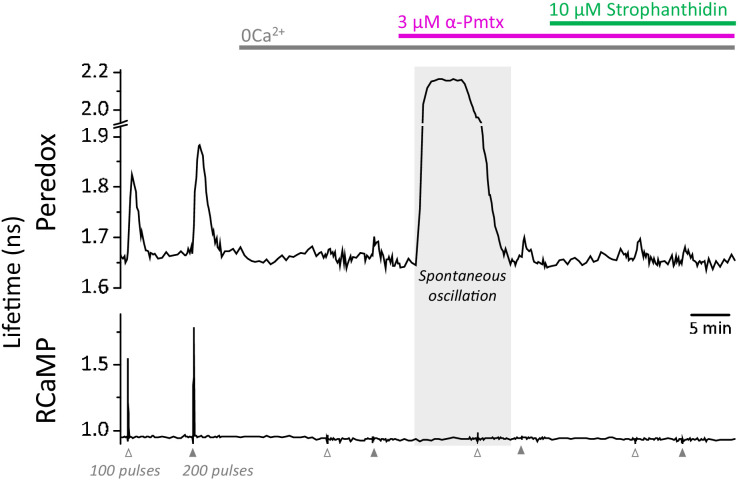
Spontaneous oscillations in the Peredox signal may occur during the prolonged application of zero Ca2+-ACSF, in the presence of EGTA and LDH inhibition.Prolonged exposure to a nominal Ca2+-free solution, plus LDH inhibition, caused spontaneous elevations of the Peredox lifetime in 25 ± 13% of the cells in each slice (slices = 10, mice = 5), contrasting with only ~3% of cells exposed to a brief exposure as in Figure 4c. The spontaneous elevations in Peredox lifetime occurred at any time after removing Ca2+ from the ACSF. Although these neurons were not included in the analysis, once the spontaneous transients cleared, the experiment resumed as usual. The continuous presence of 1 mM EGTA and 2 µM GSK-2837808 (LDH inhibitor) is not indicated in the figure for simplicity. In the control ACSF, the [Ca2+] was adjusted accordingly to yield a free concentration of 2 mM.